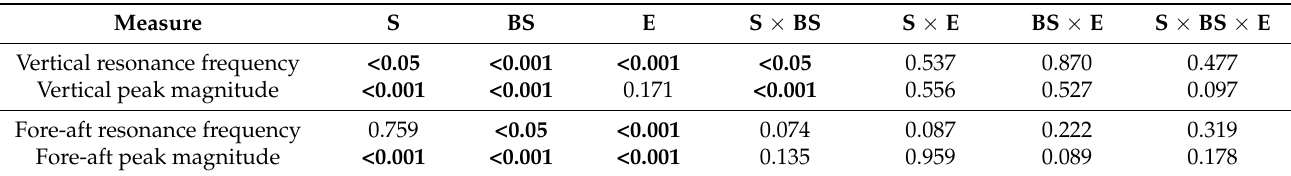
Table 5. p –values obtained from a three-factor (S, BS and E) ANOVA on the primary resonance frequency and peak STHT